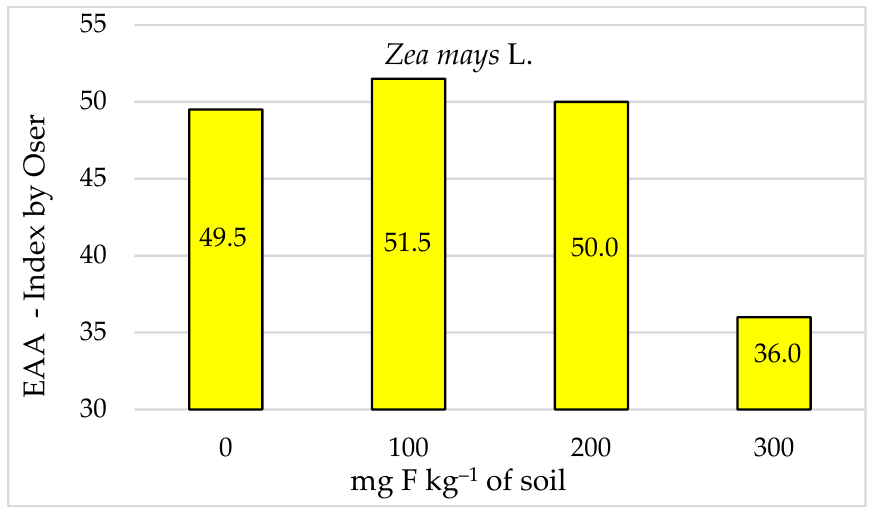
Figure 1. Nutritive value of protein accumulated in the aerial mass of maize depending on fluorine application to soil. Table 2. Residual effect of fluorine application to soil on the amino acid content in aerial mass of yellow lupine. Amino